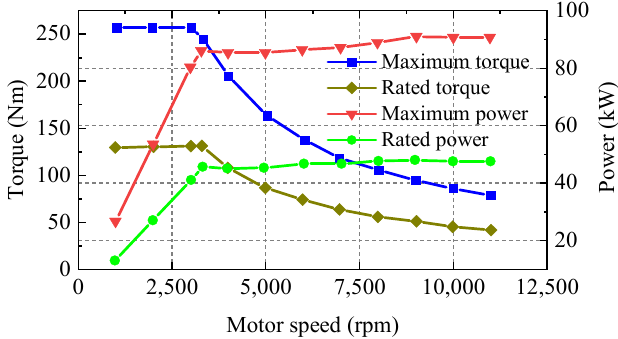
Figure 4. Toque and power characteristics of the